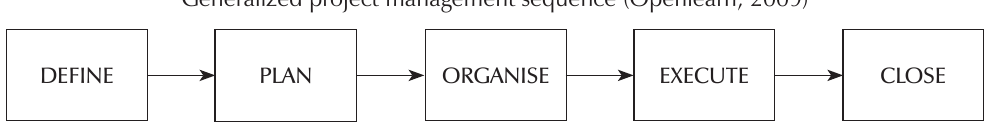
deliverables are to be generated during each phase; how each deliverable is reviewed, verified and validated; what parties are involved during each phase; and how to control and evaluate each phase (in a decision-making